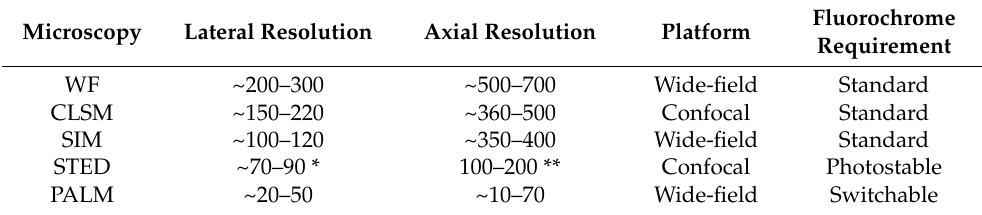
Table 1. Comparison of practical resolutions (in nm) of wide-field (WF), confocal laser scanning microscopy CLSM, structured illumination microscopy (SIM), stimulated-emission depletion (STED), and single-molecule localization microscopy